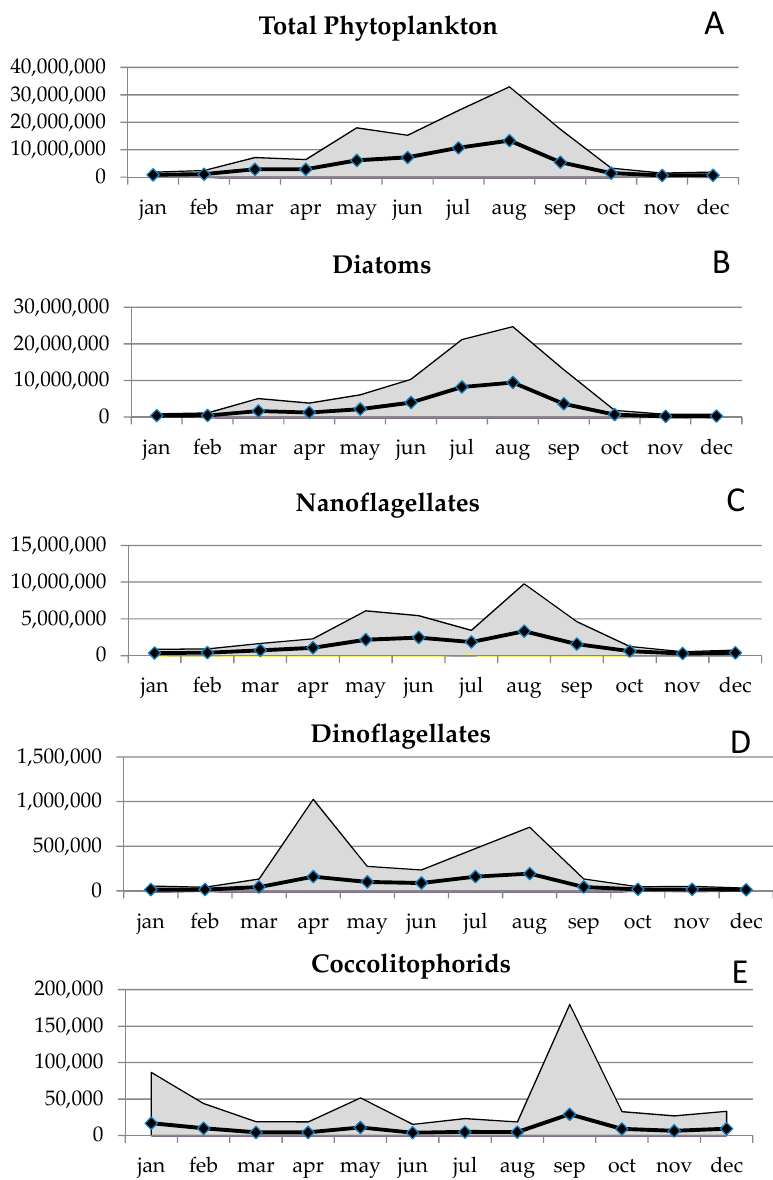
Figure 2. Seasonal patterns of mean monthly abundance (cells L − 1 ) of ( A ) total phytoplankton abundance. ( B ) diatoms, ( C ) nanoflagellates, ( D ) dinoflagellates and ( E ) coccolithophorids. Black lines and shaded areas represent, respectively, the average values and the standard deviations over the 20 years.